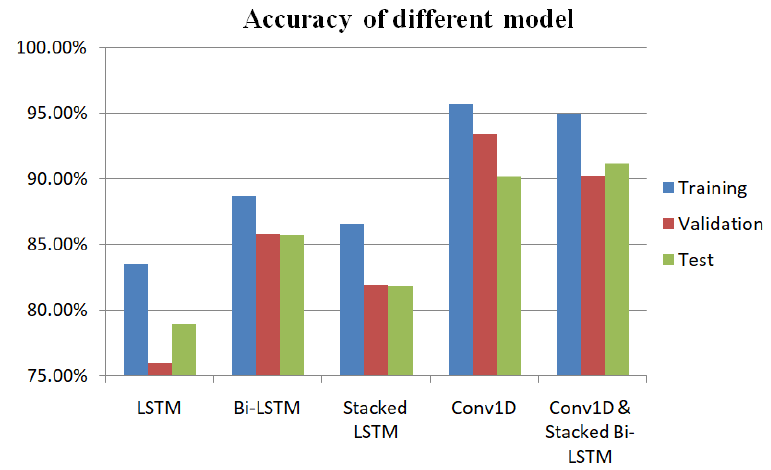
Figure 4. ( a – e ) Graphical illustration of epochs versus accuracy of each network for training and validation dataset.